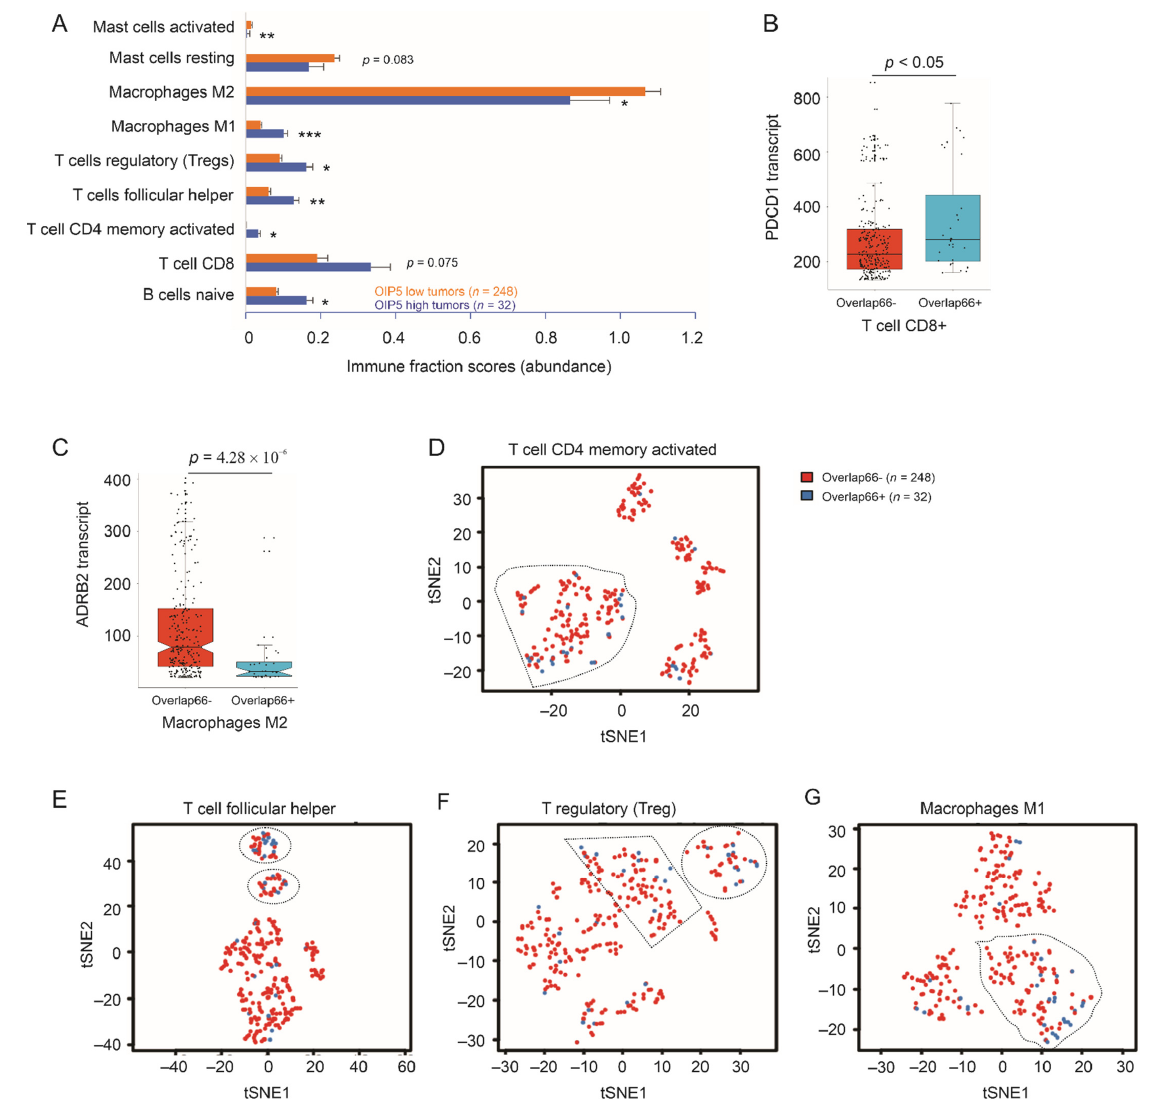
Figure 8. Changes in immune cells in pRCC tumors with high risk of fatality. RNA-seq profiles for 280 pRCC tumors were retrieved from cBioPortal and analyzed for immune cell profiles using the LM22 signature matrix and the CIBERSORTx program (https://cibersortx.stanford.edu/index.php, accessed on 21 July 2021) [47]. The analysis setting was with B-mode batch correction and 500 permutations (https://cibersortx.stanford.edu/index.php, accessed on 21 July 2021). ( A ) The abundance of the indicated immune cell subsets was determined by their immune fraction scores. Means ± SEMs in high-risk and low-risk tumors stratified by Overlap66 risk score are graphed; *: p < 0.05; **: p < 0.01; and ***: p < 0.001 in comparison to low-risk tumors by 2-tailed t -test. ( B , C ) Boxplots for the expression of PDCD1 and ADRB2 in low- and high- risk pRCC tumors; statistical analyses were conducted using Welch t -test with p -value adjusted with the Holm–Bonferroni (Holm) method. ( D – G ) Clustering of the indicated immune cell types associated with low risk (Overlap66 − ) and high risk (Overlap66+) tumors by tSNE (t-distributed stochastic neighbor embedding); the marked clusters are enriched with high-risk tumors. The graph was produced using CIBERSORTx (https://cibersortx.stanford.edu/index.php, accessed on 21 July